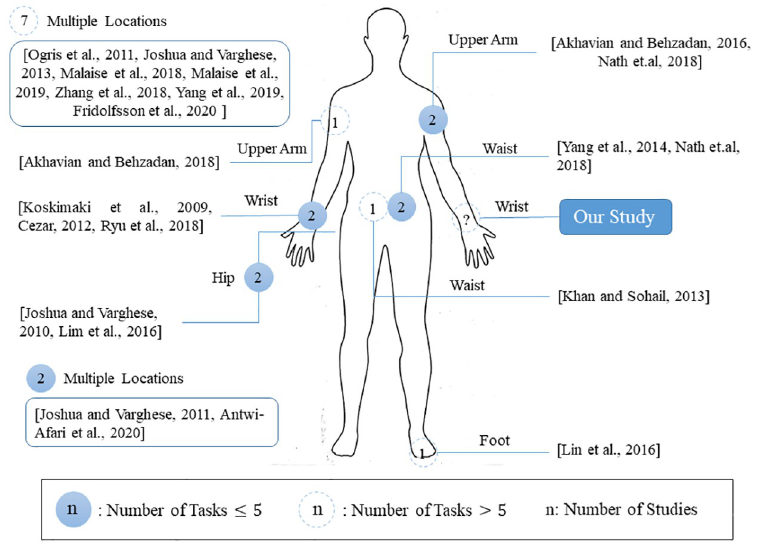
Fig 2. Body locations of the wearable sensors across the reviewed studies that involved occupational tasks (20 studies).